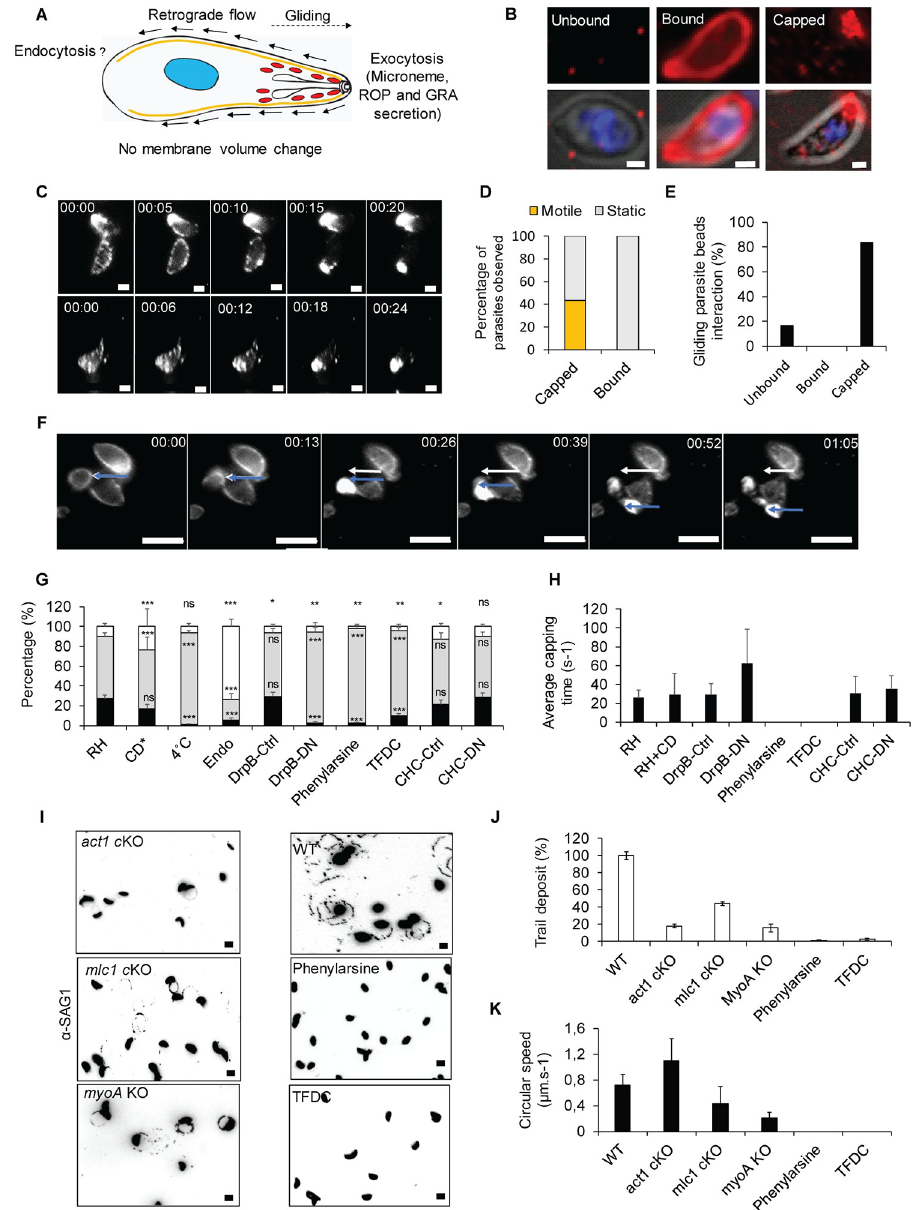
Fig 1. Evidence for involvement of endocytosis in T . gondii motility. (A) Fountain-flow model described for Dictyostelium by Takana and colleagues 2017 [13], applied to T . gondii . While it was demonstrated that motility depends on the apical secretion of micronemes, the role of endocytosis to ensure membrane balance and recycling is unclear. (B) Representative pictures of the three phenotypes observed in the bead translocation experiment. Unbound: parasite without beads, that either did not interact or lost its interaction with the beads; Bound: parasite with beads around the plasma membrane; Capped: parasite that translocated bound beads to its basal pole. Scale bar, 1 μ m. (C) Time-lapse analysis of bead translocation. Parasites were incubated with latex beads. Capping was recorded by live microscopy to determine the average time required for capping. Scale bar, 1 μ m. (D) Quantification of motility in capped and bound parasites. Capped: n = 175; Bound: n = 166. (E) Quantification of gliding parasites in combination with bead translocation. Only parasites with unbound (no beads) and capped beads (beads accumulated at the posterior end) were observed gliding. No instances in which beads were bound at the plasma membrane, but not capped, were observed; n = 38. (F) Time-lapse illustration of a parasite that translocated beads and initiates gliding motility. Scale bar, 5 μ m. The white arrow indicates the initial position of the basal pole of the parasite. The blue arrow indicates the actual position of the basal pole of the parasite. Capping occurred within the first 26 seconds, and then the parasite initiated motility. (G) Quantification of bead translocation using indicated inhibitors or parasite